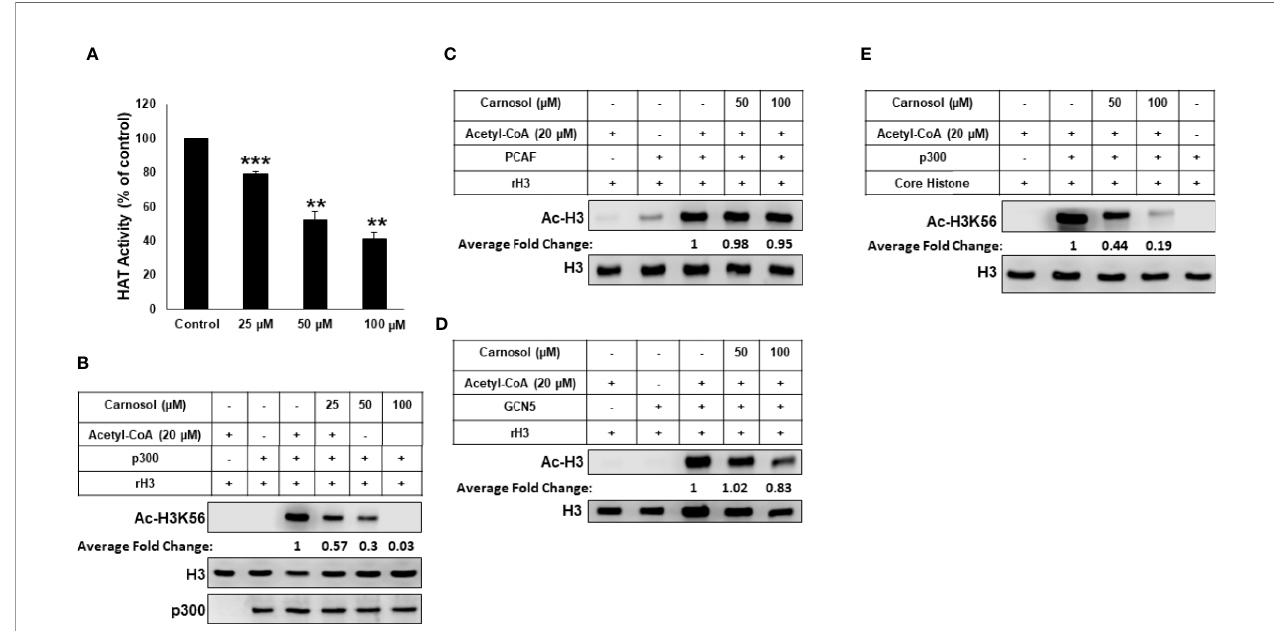
FIGURE 4 | Carnosol is a speci fi c p300 inhibitor in vitro. (A) Carnosol inhibit histone acetylation in vitro . HAT assay with HeLa nuclear extract in the presence of increasing concentrations of carnosol. Values represented in percent were calculated from three independent experiments carried out in triplicate and are represented as mean ± SEM. ( **p < 0.005 , ***p < 0.001 ). (B – D) Carnosol inhibits P300 (B) but not PCAF (C) or GCN5 (D) . HAT assay was performed with p300 catalytic domain (aa 1,284 – 1,673), recombinant PCAF and recombinant GCN5, recombinant H3 with or without increasing carnosol. HAT activity was measured by Western Blotting scoring for acetylated histone H3. (E) HAT assay was performed with recombinant p300 catalytic domain (aa 1,284 – 1,673) and core histone with or without carnosol and HAT activity was measured as in (B) . Data shown for all HAT assays are representative of three independent experiments. The intensities of the bands were quanti fi ed using the ImageJ software (National Institute of Health,